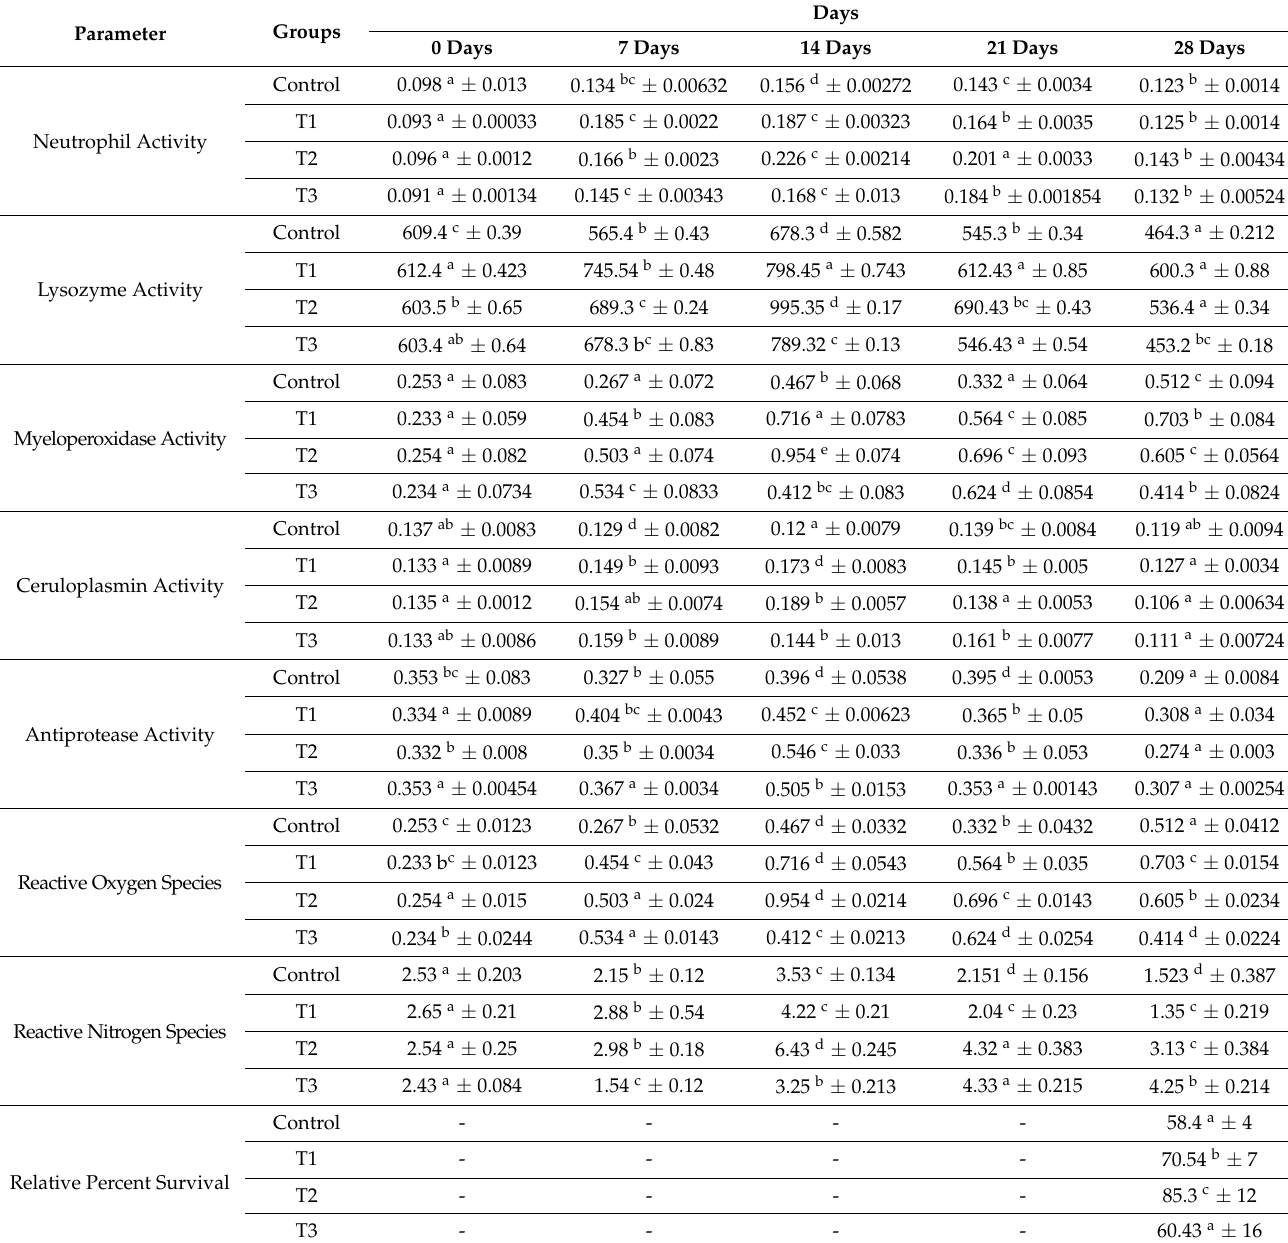
Table 1. Values (Means ± SE) of various non-specific immune response parameters and relative percent survival of Labeo rohita , after treatment with extract of green algae ( Chaetomorpha aerea ) against Edwardsiella tarda